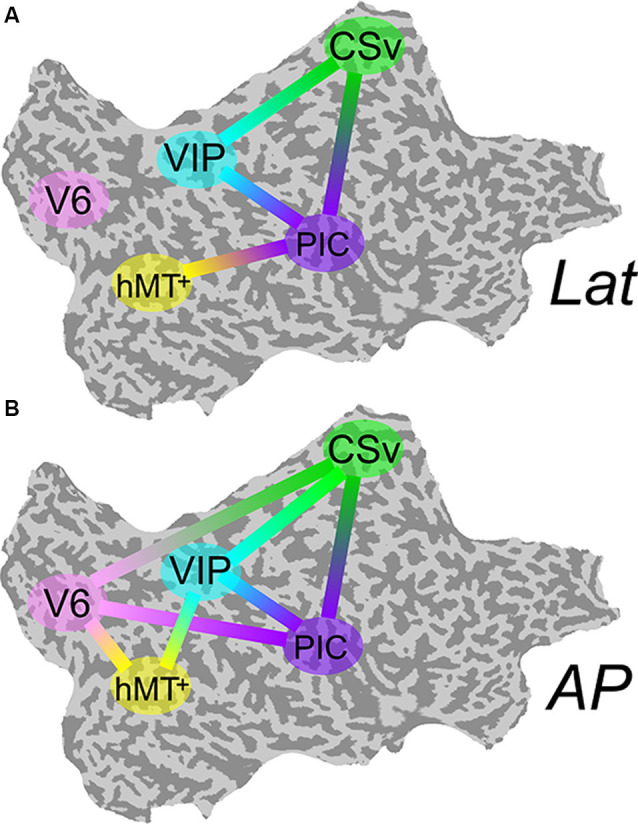
Psychophysiological interaction (PPI) functional connectivity analysis. Multiregional PPI was run across the five ROIs identified in the localizer protocol. Results are shown for the Lat (A) and AP (B) GVS conditions. A solid line between two ROIs corresponds to a connection that is significantly stronger during this condition (P < 0.001) than during baseline.